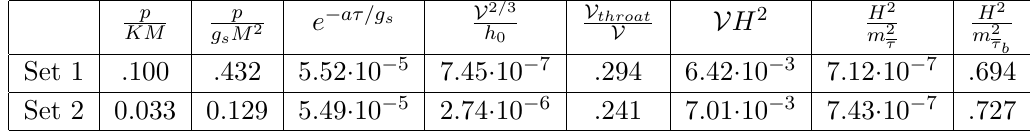
Table 7 . All the constraints mentioned in section 4.1 are satis(cid:12)ed by both parameter sets.